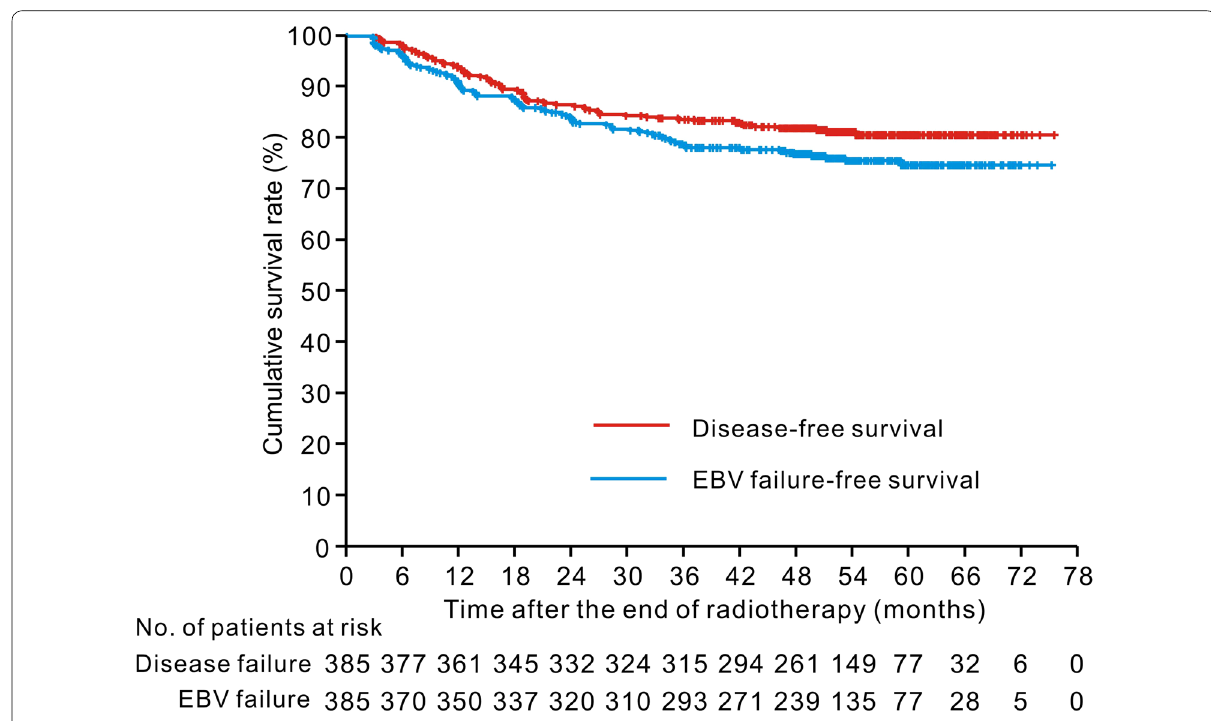
Fig. 1 Kaplan–Meier disease‑free survival and Epstein–Barr virus (EBV) failure‑free survival curves for the 385 patients with nasopharyngeal carci‑ noma who were treated with intensity‑modulated